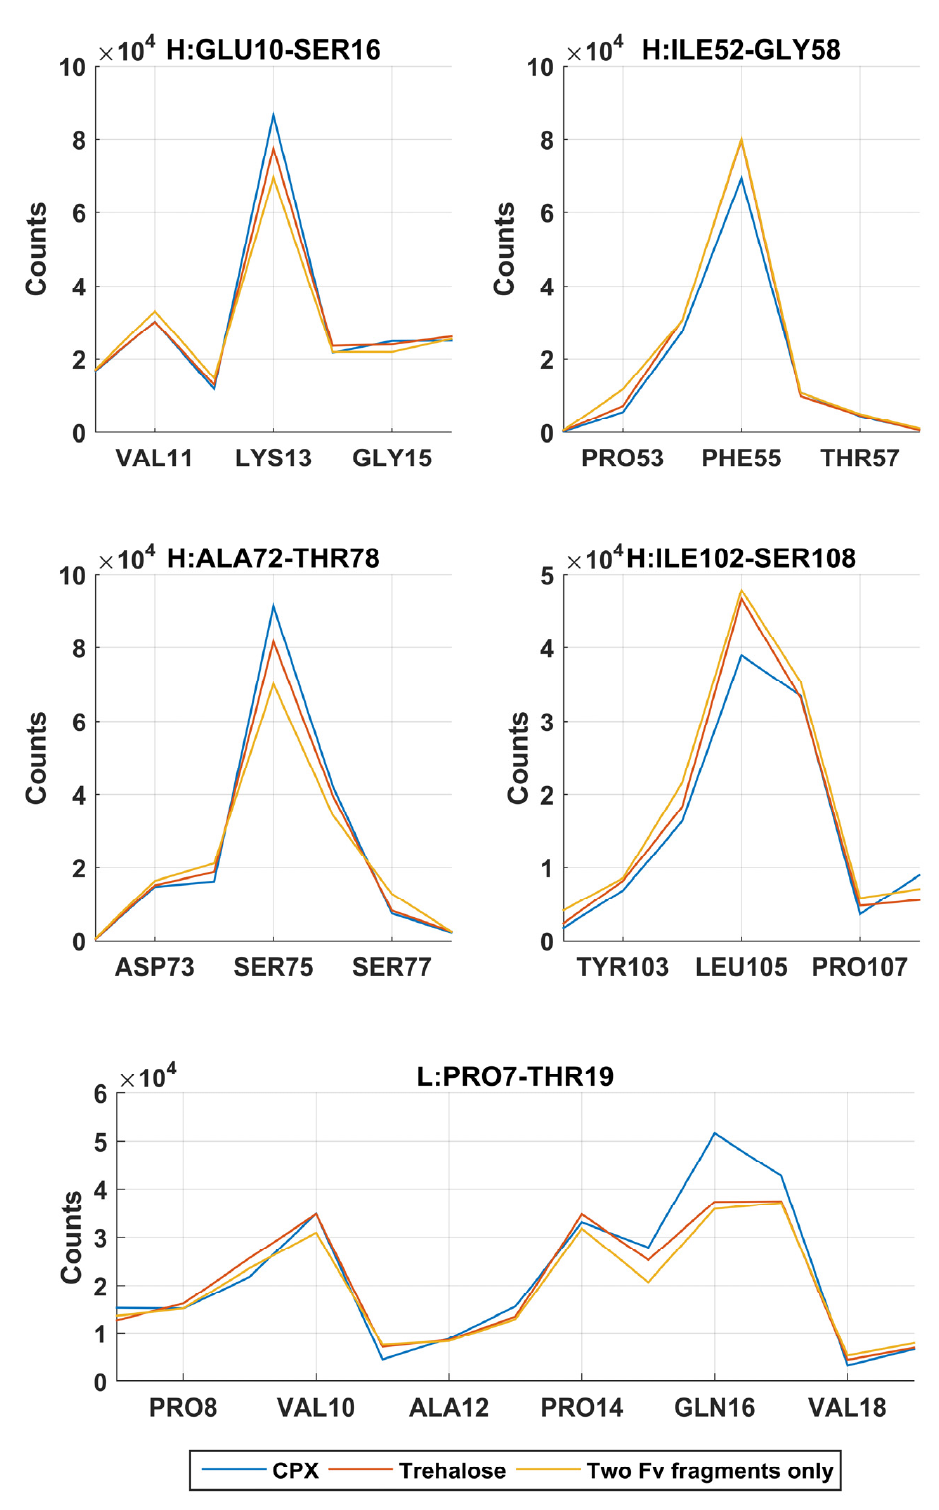
Figure 8. The common interaction locations in a set of 1024 MARTINI CG simulations in under three conditions (1) two mAb1 Fv fragments in 100 mM NaCl, (2) with 10 molecules of Compound X and (3) with 10 molecules of Trehalose. Selective excipient Compound X binds to the most solvent-accessible hydrophobic patch at LEU105 on the heavy chain and is shown to reduce antibody– antibody interactions via this residue while increasing interactions through GLU16 on the light chain and LYS13 and SER75 on the heavy chain.